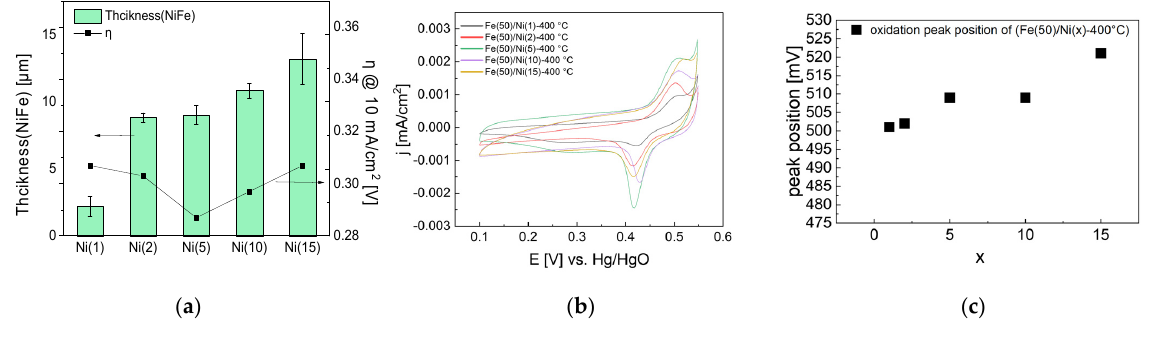
Figure 9. Electrochemical analysis of NiFe-oxide electrodes varying with respect to Ni coating concentration: ( a ) Thickness of NiFe-oxide layers shown with overpotential at 10 mA/cm 2 after 4 h CC (1.5 A/cm 2 ) operation, ( b ) CV cycles of NiFe-oxide electrodes after 4 h CC operation and ( c ) CV oxidation peak position after 4 h CC operation. Because the thickness is uneven, thickness at three different points was measured and averaged.